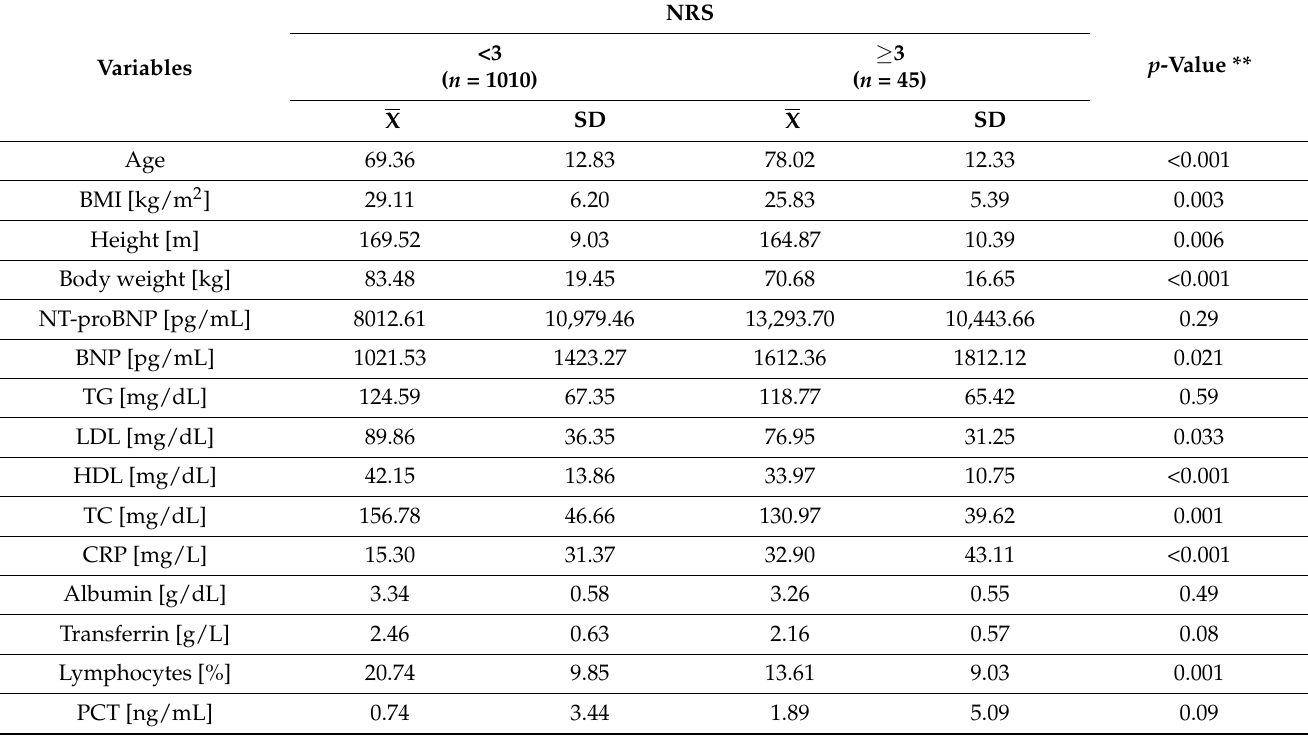
Table 5. The comparison of assessed parameters (quantitative variables) with NRS scores.